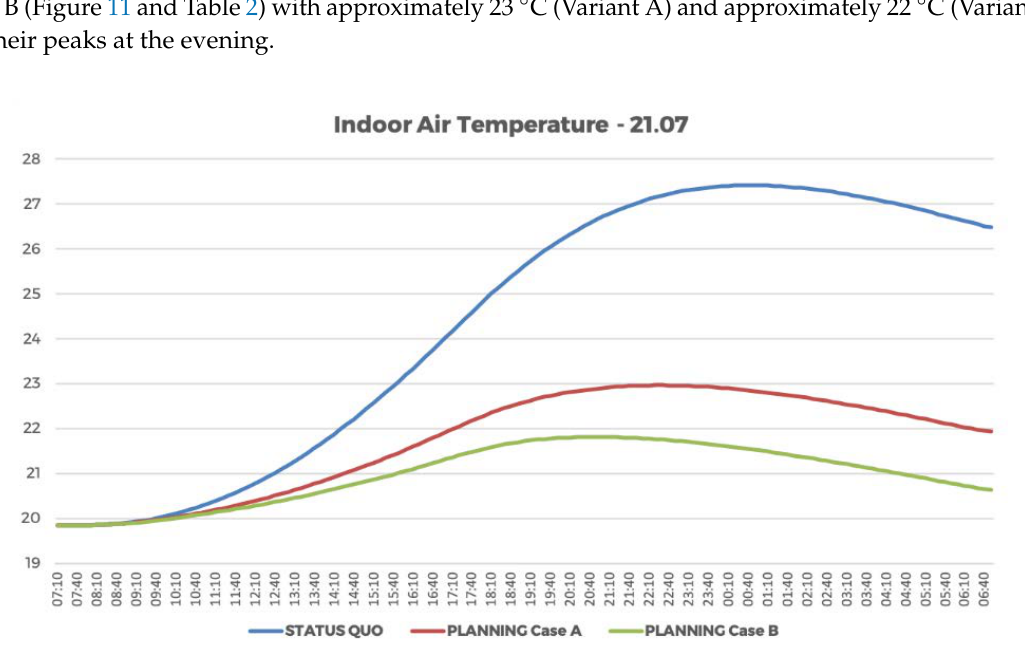
Table 2. Indoor air temperature for Elief Playhouse variants on an idealized hot summer day (21.07).